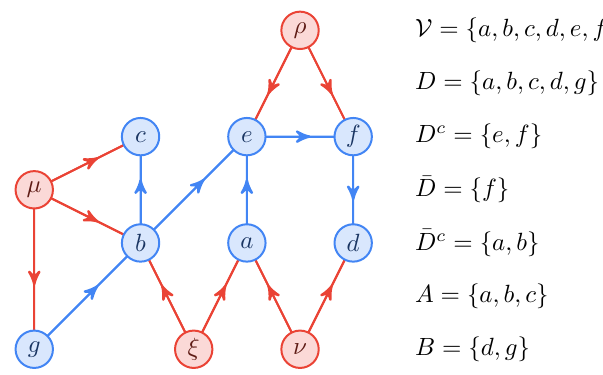
Figure 21: A causal structure G 21 that helps in visualizing the proof of Theorem